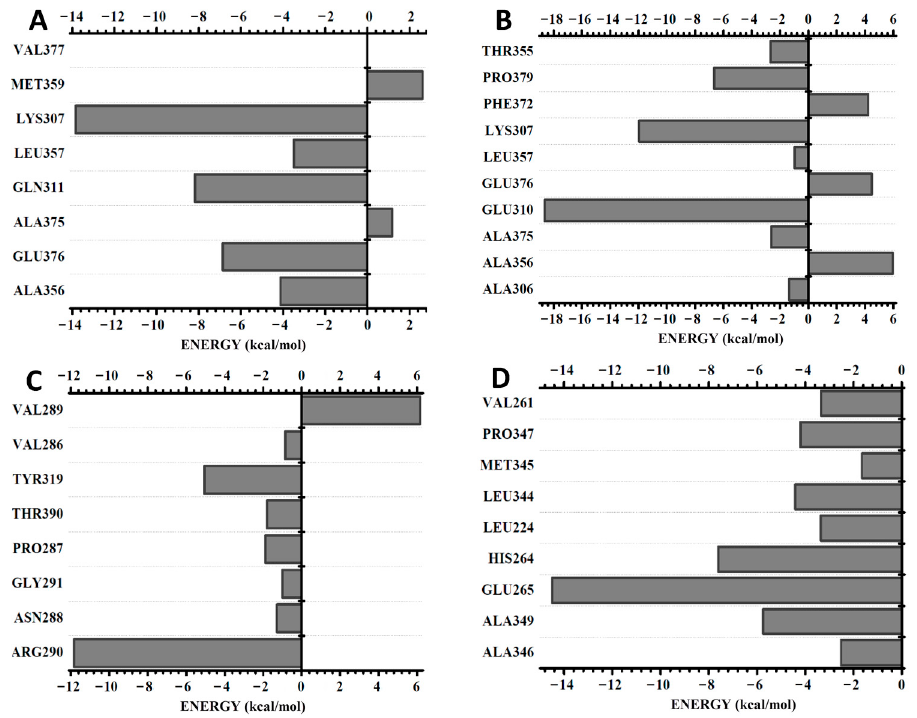
Figure 2. BIRD graphic panel showing the most relevant residues of the gp63 contributions that bind to the ligands: ( A ) DETC, ( B ) DOXY, ( C ) terpinen-4-ol, and ( D ) L1. Distances (Å) are indicated and binding energy is shown in kcal/mol.